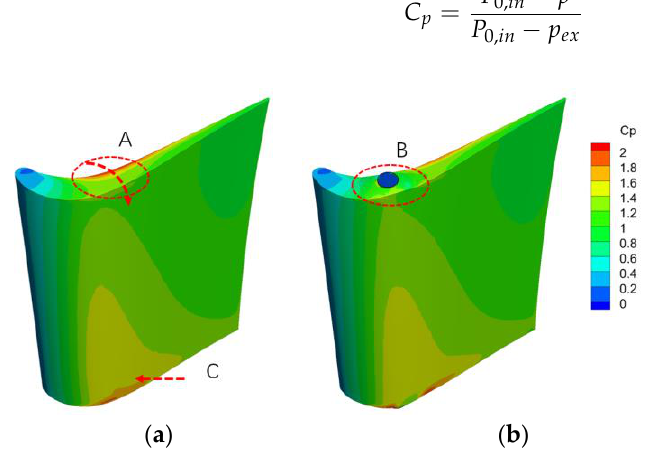
Figure 5. The cp distribution on the vane surface at design angle. ( a ) Datum ( b )